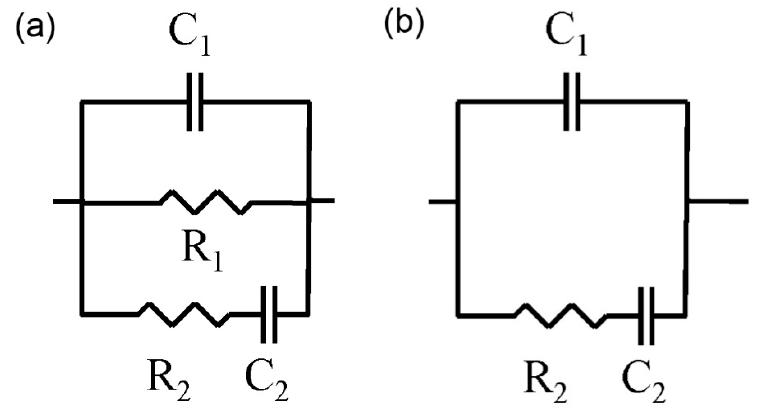
Figure 5. ( a ) Equivalent circuit used for the fitting of the impedance spectra obtained using the contacting method; ( b ) equivalent circuit used for the fitting of the impedance spectra obtained using the non-contacting method.